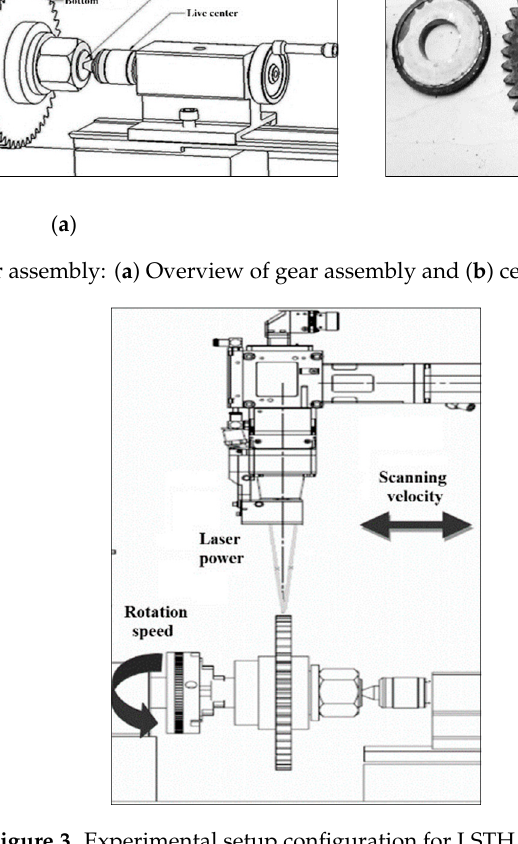
Figure 3. Experimental setup configuration for LSTH of gears.